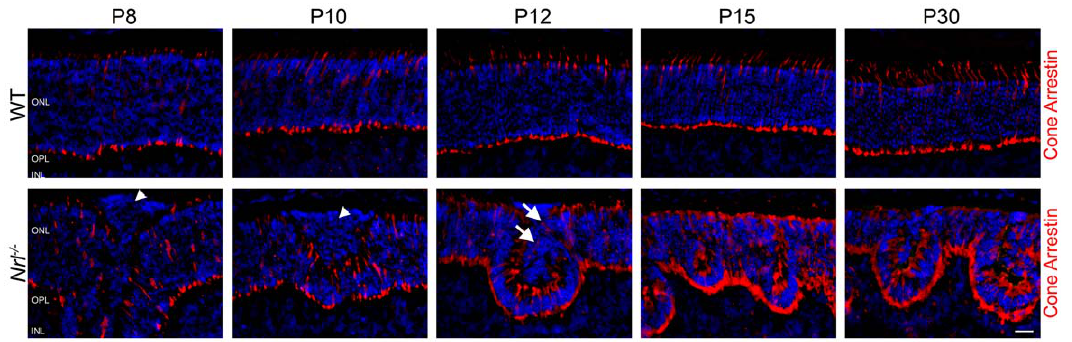
Figure 4. Early aberrant photoreceptors are not positive for cone arrestin. In order to further analyze the development of the cone photoreceptors in the Nrl 2 / 2 retina, cone photoreceptor cell bodies were stained using an antibody against cone arrestin (red). In the WT retina an even distribution of cone arrestin positive cells are observed throughout the retina and at all time points. Early aberrant photoreceptors at P8 and P10 lack significant staining for cone arrestin (arrowheads). At P12 cone arrestin staining is observed within the population of aberrant photoreceptors (Arrows). In the Nrl 2 / 2 retina, all photoreceptors are positive for cone arrestin at P15 and in the adult Scale bar, 20 m m. doi:10.1371/journal.pone.0032484.g004 the lumen of the rosette ( Figure 5D ). Consistent with examina- between brackets in Figure 5D ) and spread into the subretinal tion on the light level, the aberrant photoreceptors are contiguous space toward the RPE ( Figure 5D ). with the ONL. The population of aberrant photoreceptors protrude through a relatively small gap in the IS layer (region